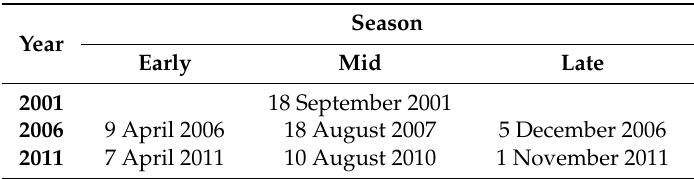
Table 1. Landsat 5 TM images used in this